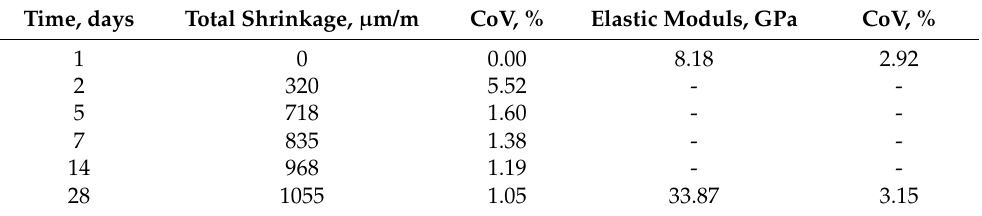
Figure 10. Fluxural strenght and statistic parameters of 3D concretes. The total shrinkage of 3D concrete was tested by the Graf–Kaufman [72] method on three samples 50 × 50 × 250 mm in the range from one to 28 days. The modulus of elasticity was tested after 24 h and 28 days according to European Standard [73]. Table 4 presents the results. Fresh mix density was 2250 kg/m 3 , while, after 28 days, hardened concrete was 2200 kg/m 3 . Table 4. Results of total shrinkage and elastic modulus for examined